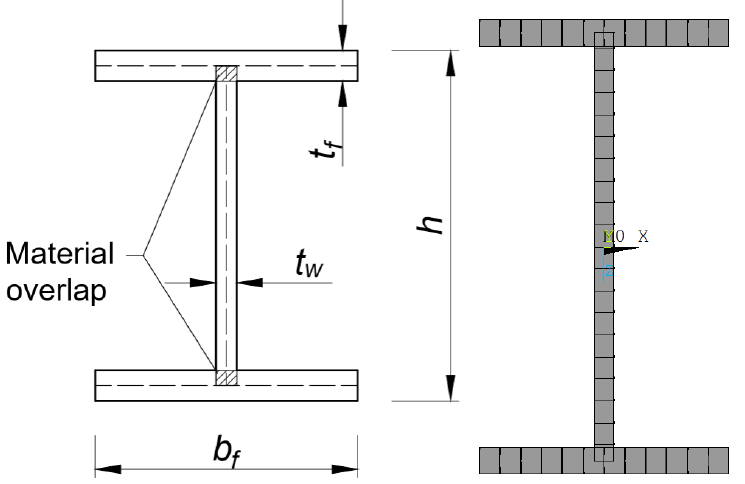
Figure 3. Material overlap using Shell elements.